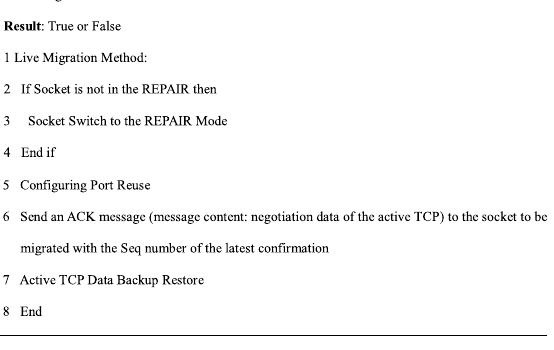
Algorithm 2. TCP_REPAIR Socket Live Migration